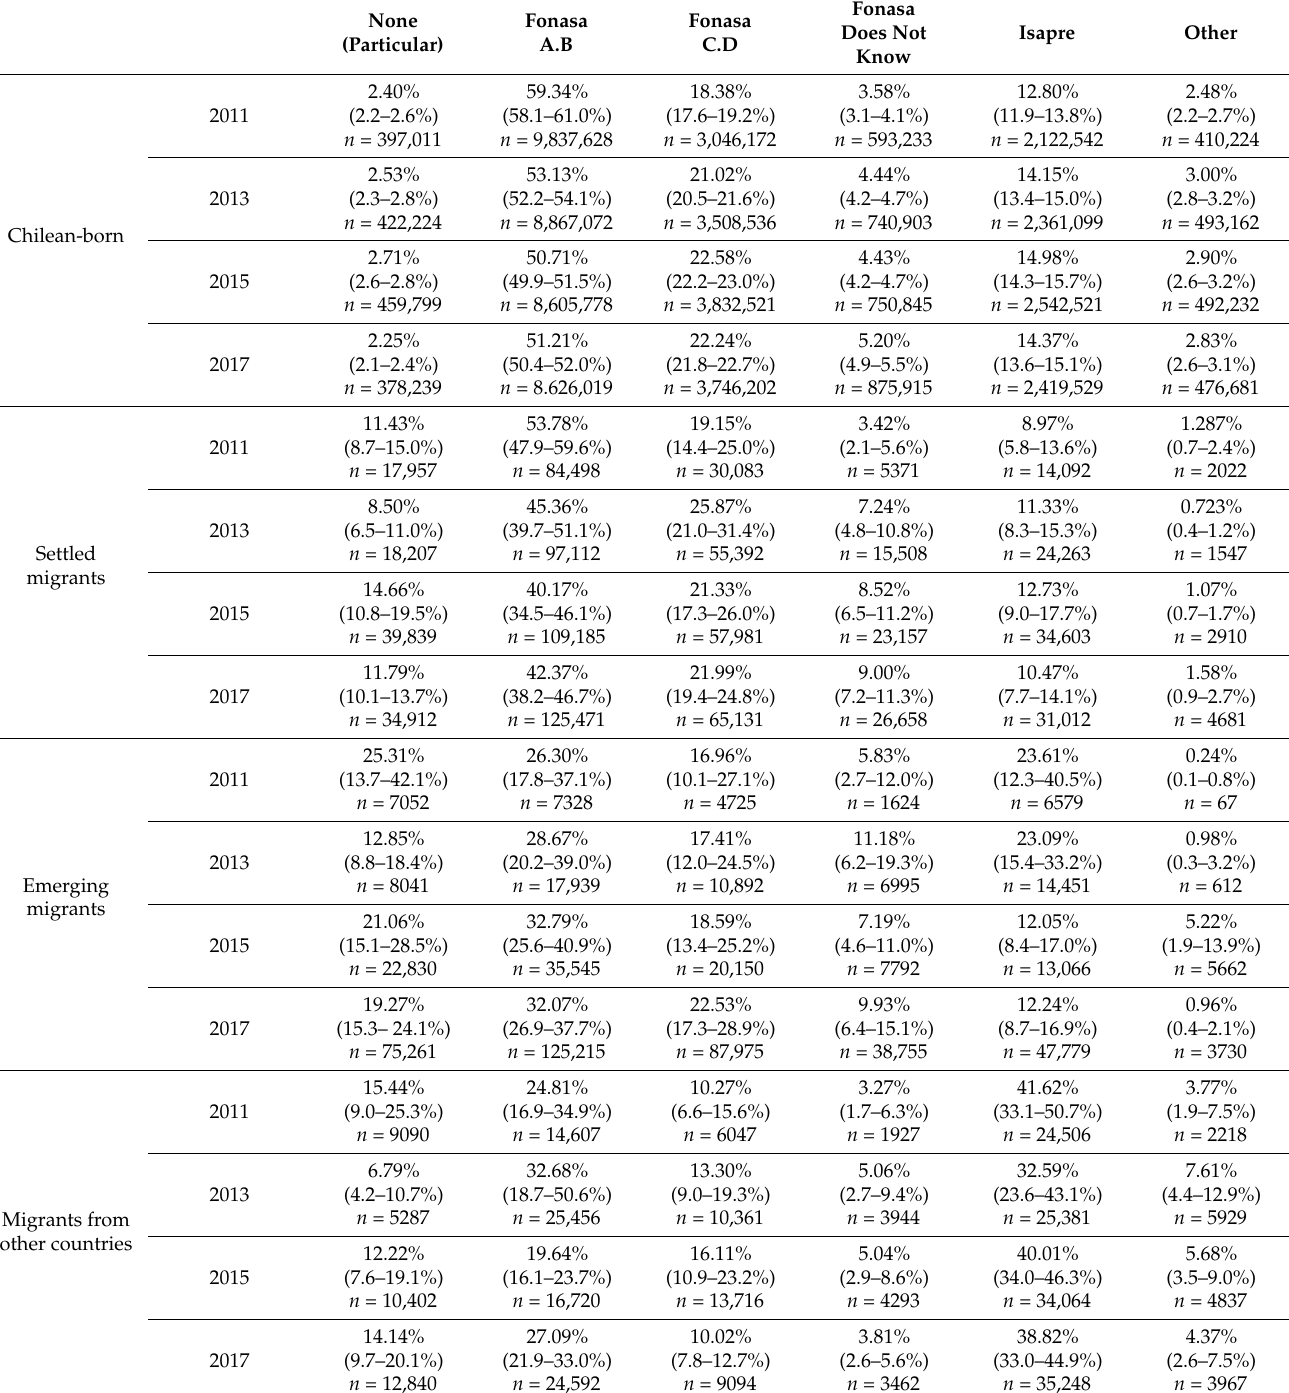
Table 2. Health care insurance in the Chilean-born population and immigrant populations (settled, emerging, and other countries). Chile